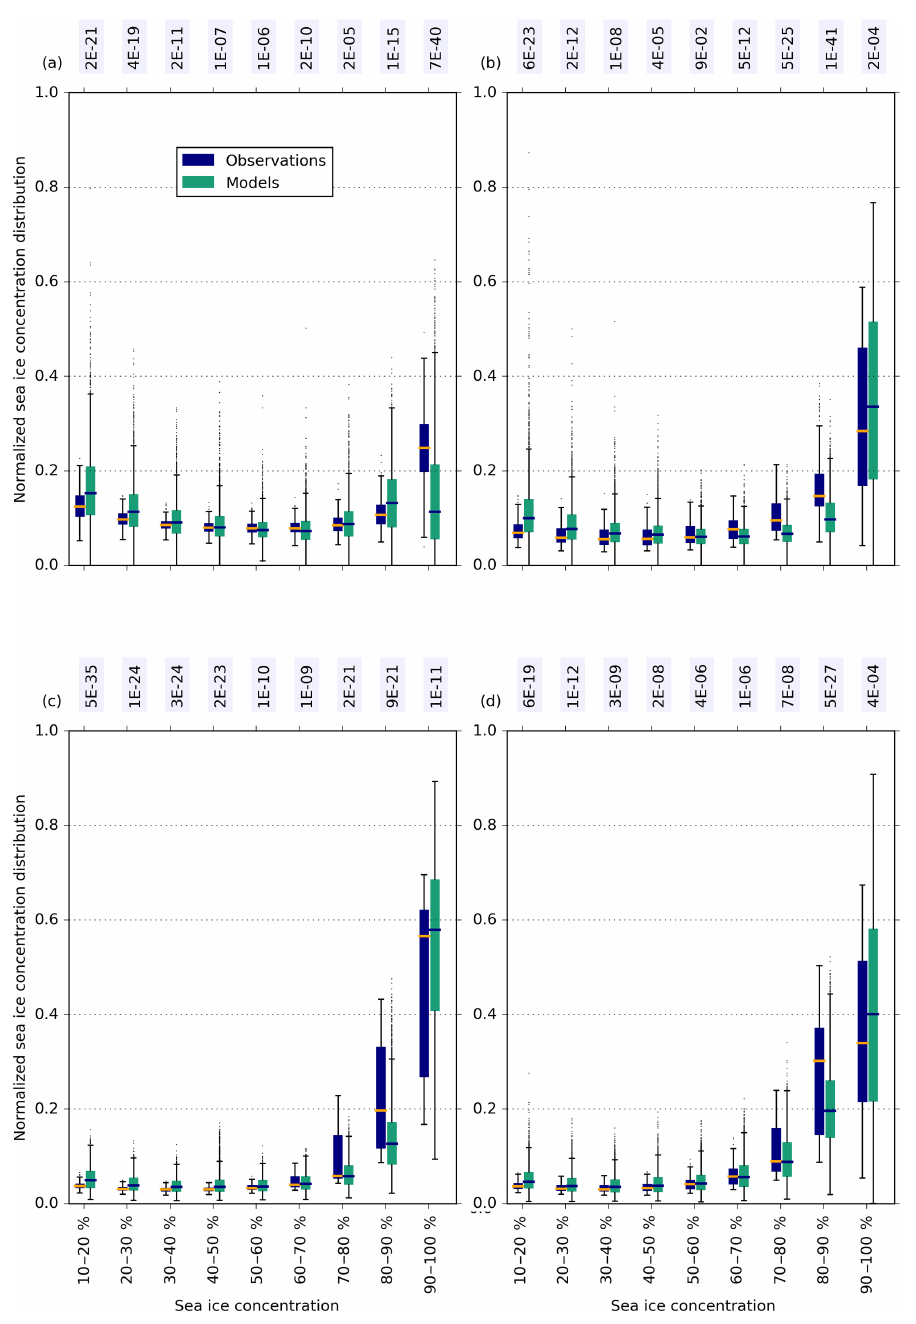
Figure 5. The normalized sea ice concentration distribution for all months in each year from 1992 to 2014 in (a) DJF, (b) MAM, (c) JJA, and (d) SON from the three sets of satellite observations (blue) and the 40 CMIP5 models (green). Box plots as in Fig. 1. Annotated text is the p value calculated from a Kolmogorov–Smirnov test, which represents the confidence that the two populations come from the same